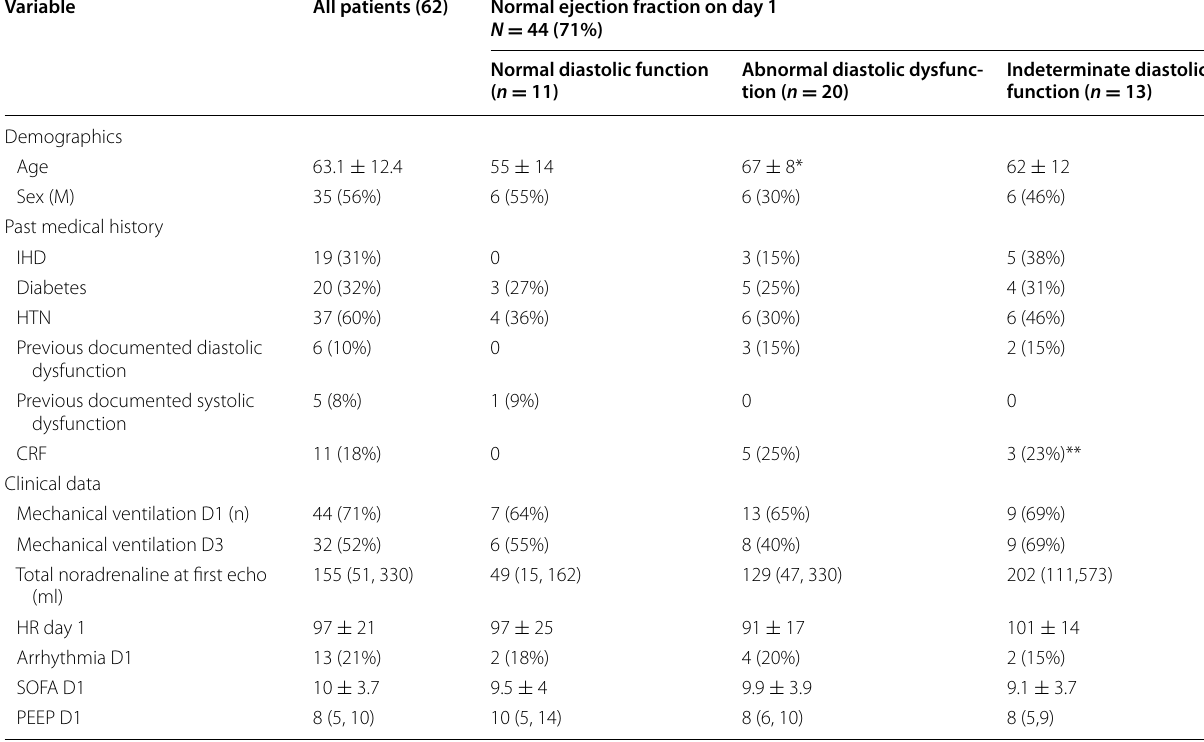
Diastolic dysfunction assessed by 2016 ASE/EACVI guidelines p values not given unless significant, * p < 0.018; ** p <